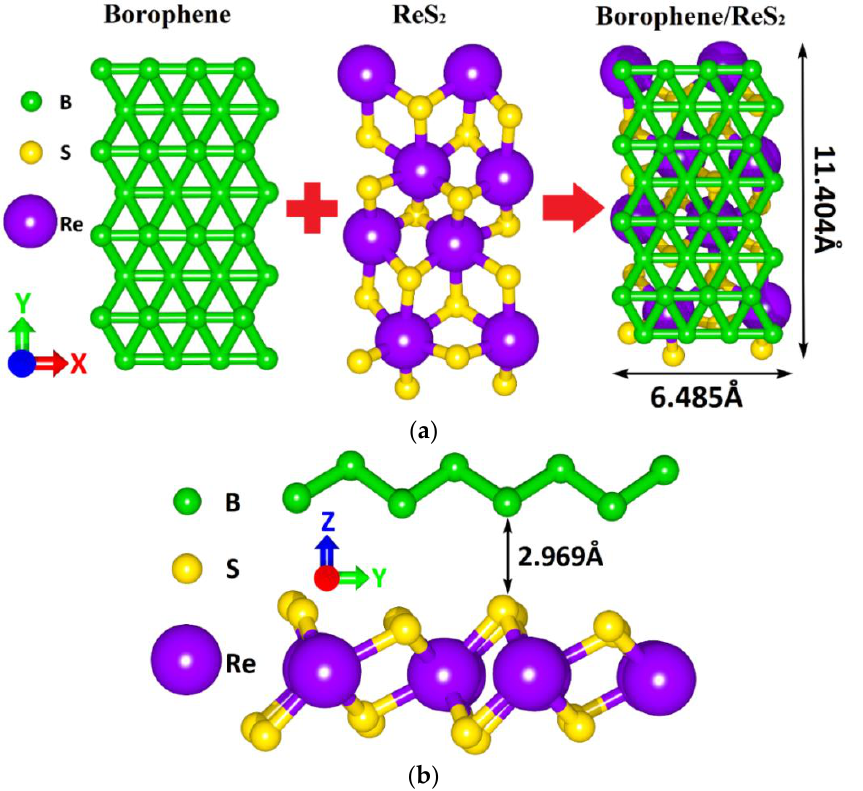
Figure 2. The process of constructing a supercell of van der Waals borophene/ReS 2 heterostructures: ( a ) top view; ( b ) side view.